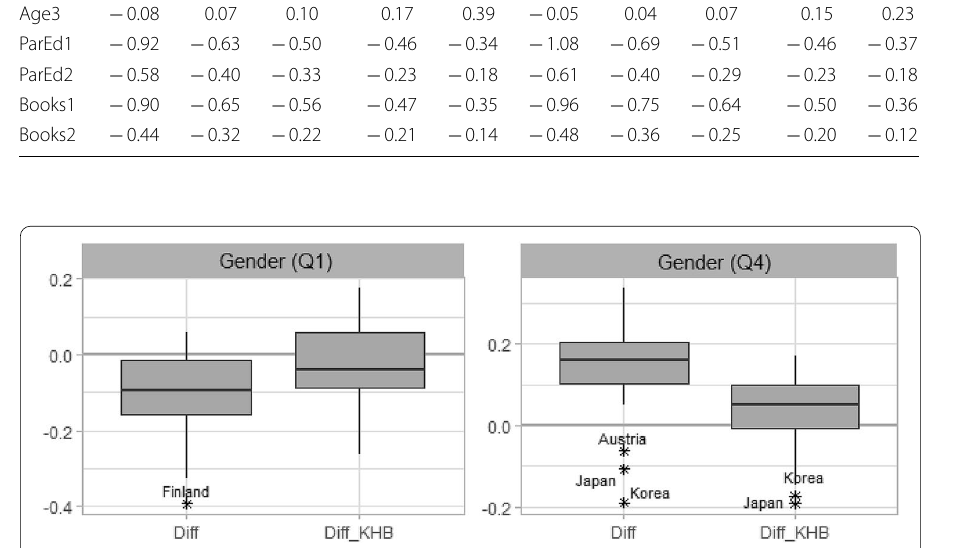
Fig. 2 Box plots of conventional differences and KHB differences for coefficients of gender [Q1 and